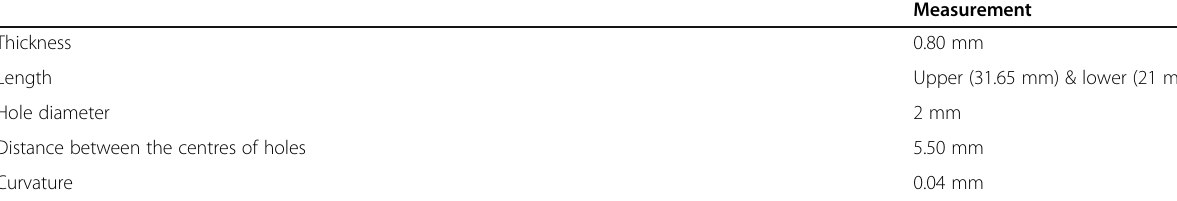
Table 1 Characteristics of the surgical miniplate (S. K. Surgicals, Pune, Maharashtra, India)